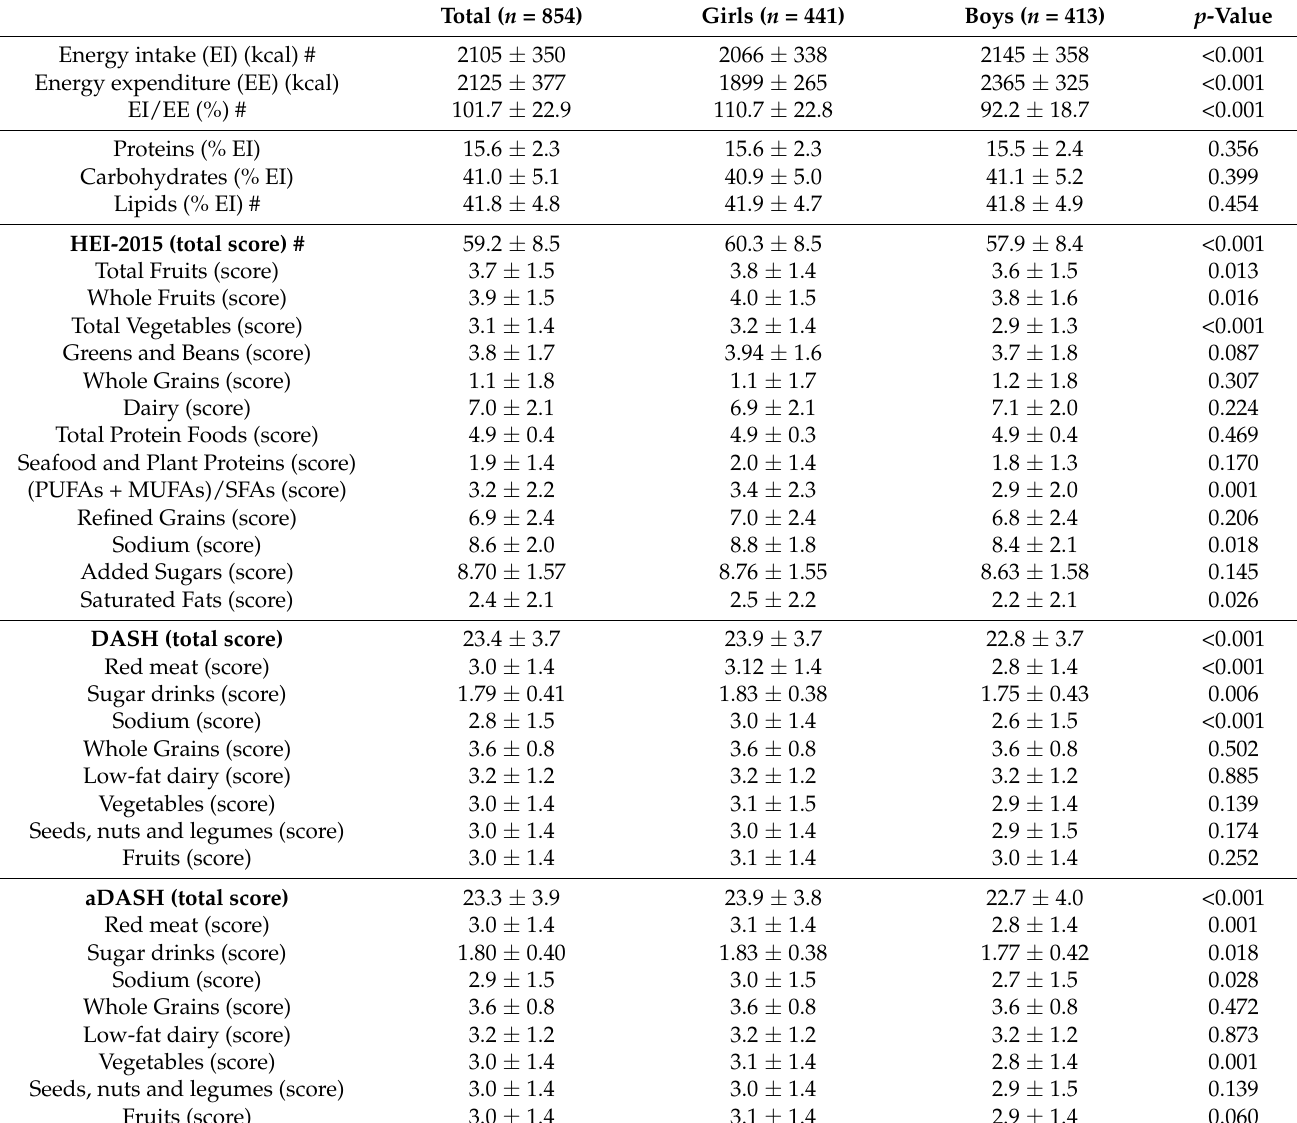
Table 2. Diet quality in the schoolchildren studied according to